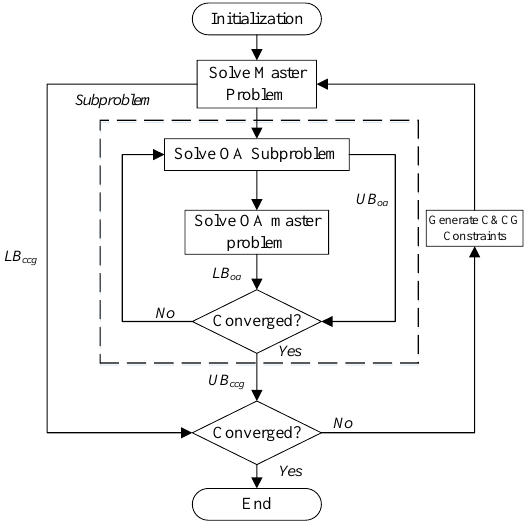
Figure 3. The framework of the algorithm.